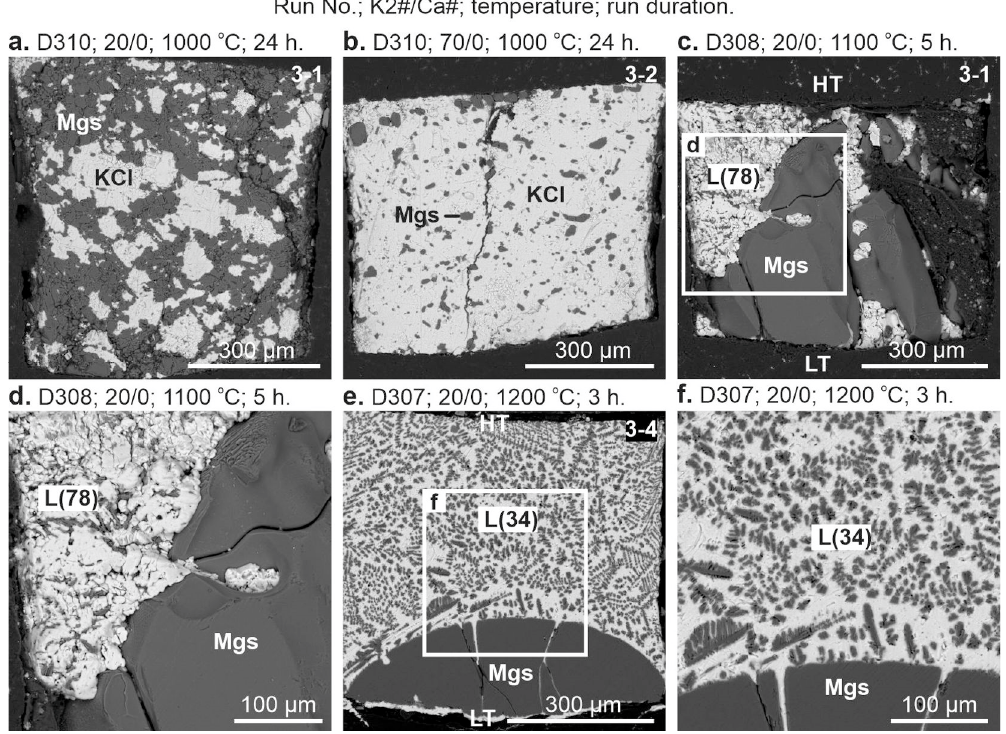
Figure 3. BSE images of sample cross-sections in the system 2KCl–MgCO 3 at 3 GPa and 1000 ( a,b ), 1100 ( c,d ), and 1200 °C ( e,f ). The numbers in parentheses denote the melt K2#. HT—high-temperature side. LT—low-temperature side. The gravity vector is directed downward.